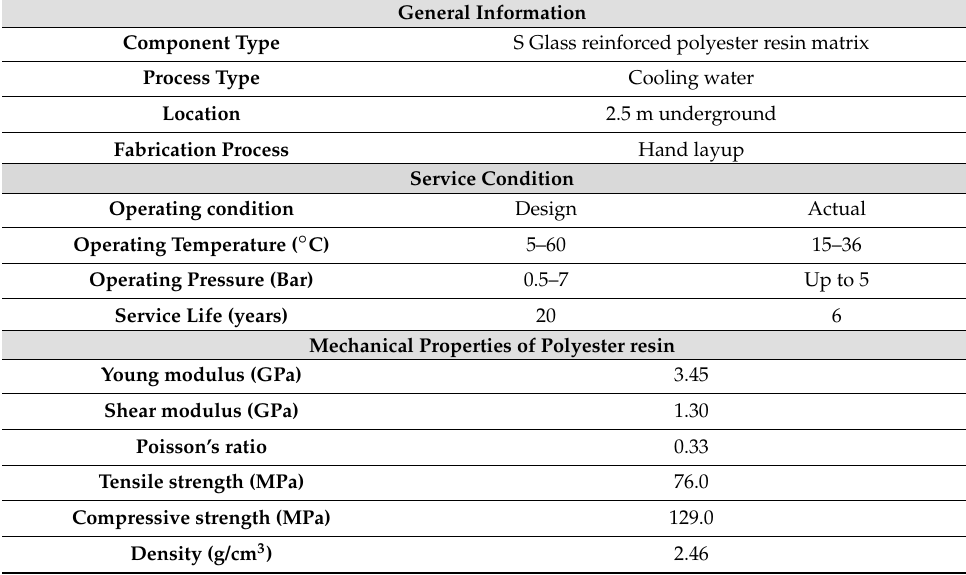
Table 1. Summary of technical details for the composite mitered